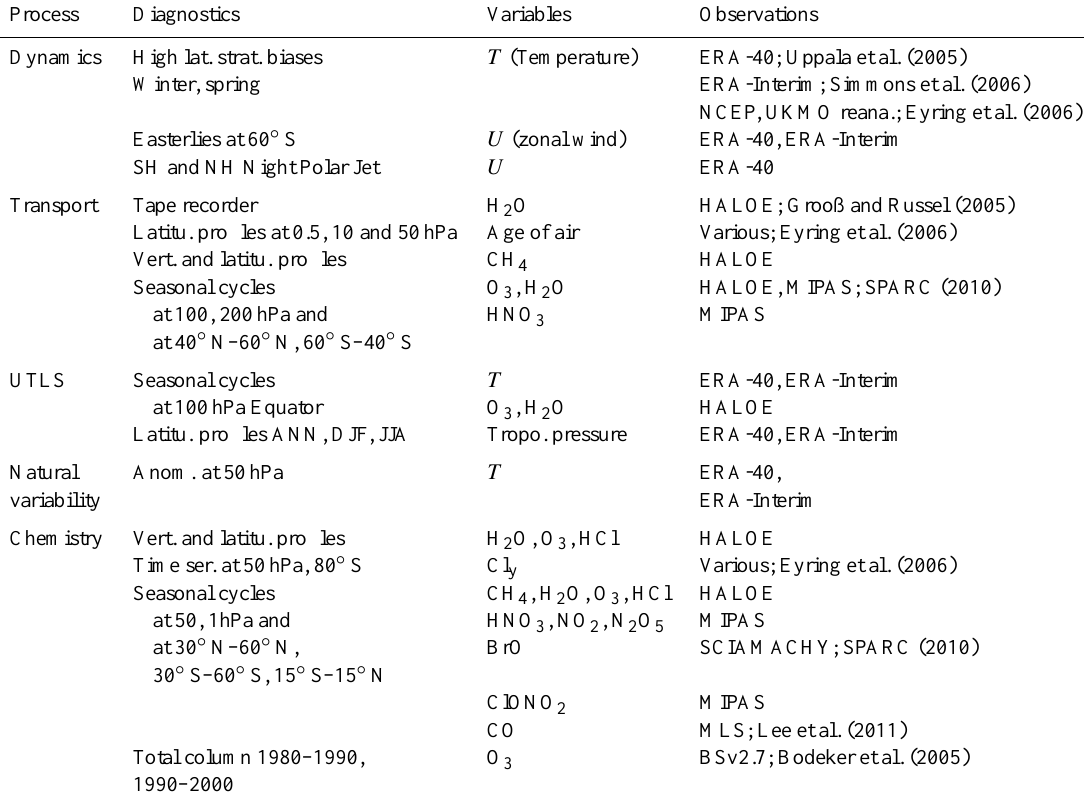
Table 1. Diagnostics considered in this